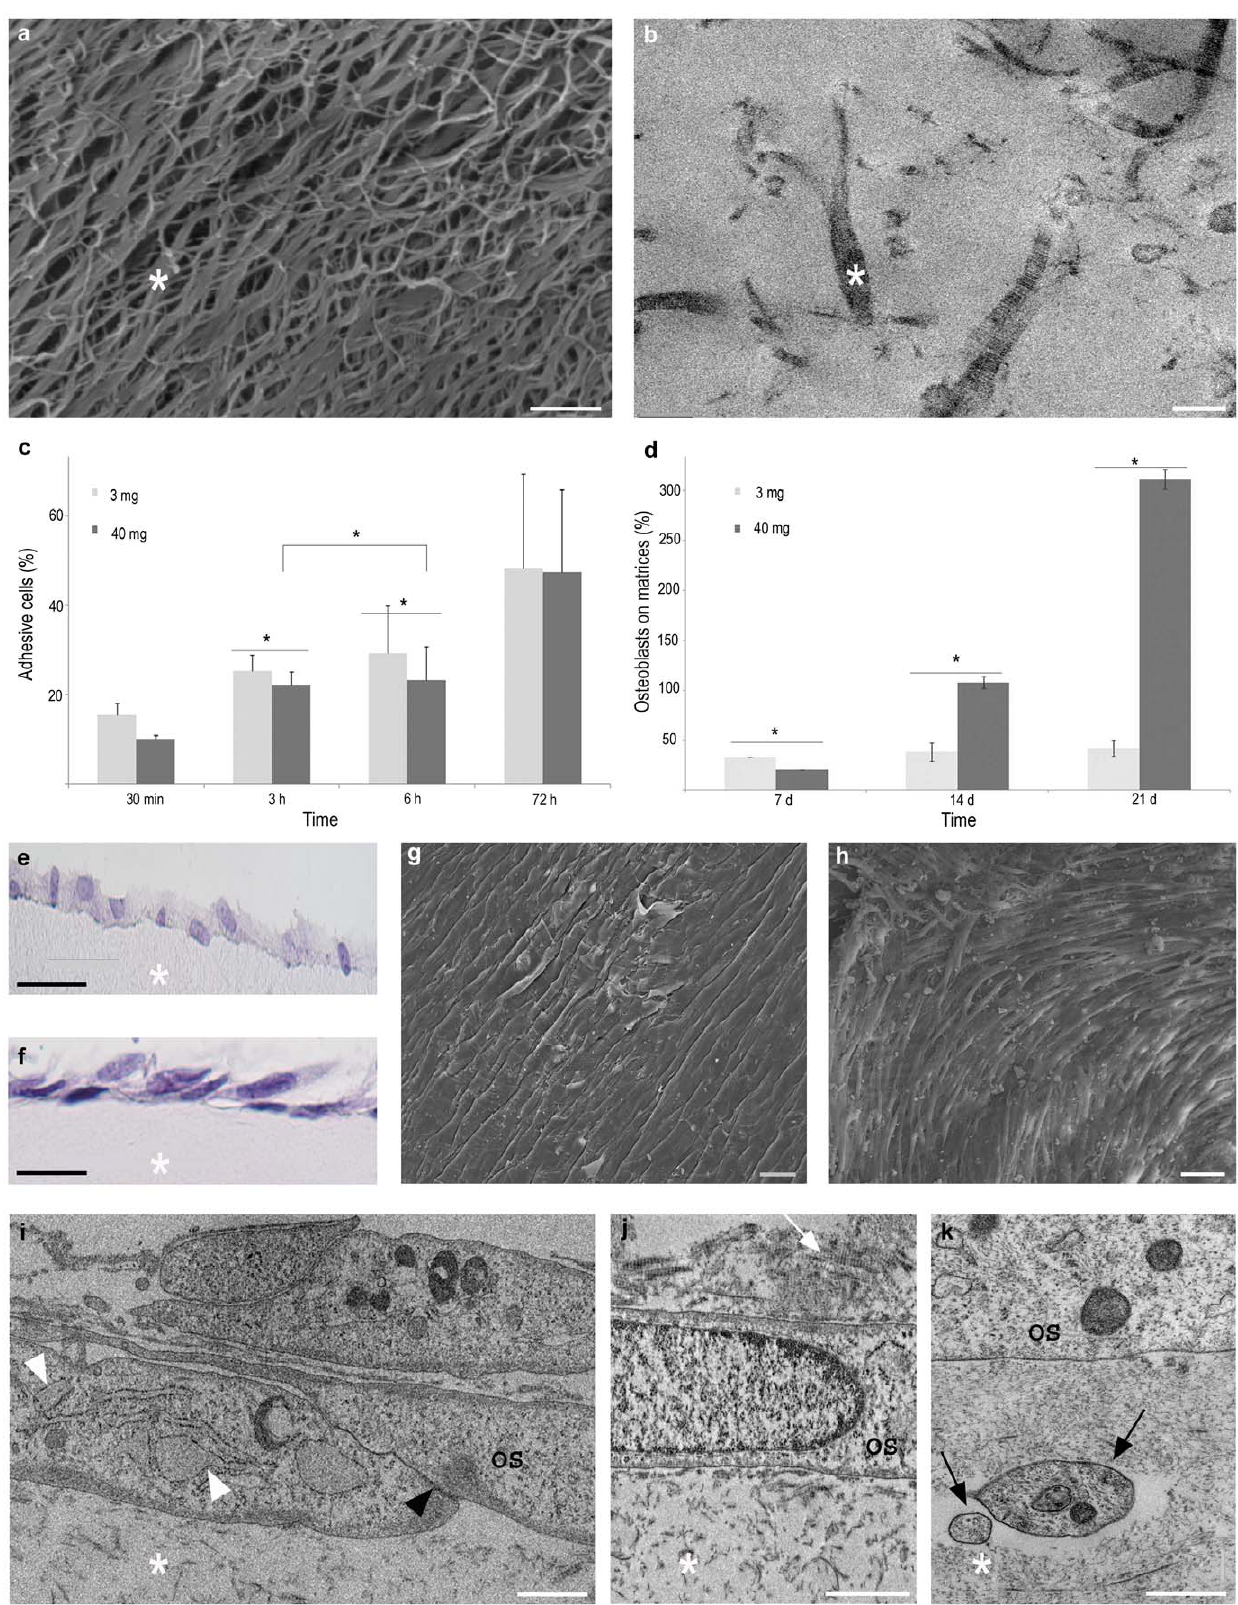
Figure 1. Matrix description and behavior of human primary osteoblasts seeded on an osteoid-like matrix. SEM (a) and TEM (b) views of the dense, 40 mg/mL, fibrillar collagen matrix (*). Scale bars: a: 1 m m, b: 100 nm. c, d: Cell adhesion over 72 hours and cell viability over 21 days analyzed by cell counting and MTT test, respectively. *=p , 0.05. e–k: Osteoblast morphology. e, f: Hemalun staining of 5 m m-thick sections at 14 and PLOS ONE |